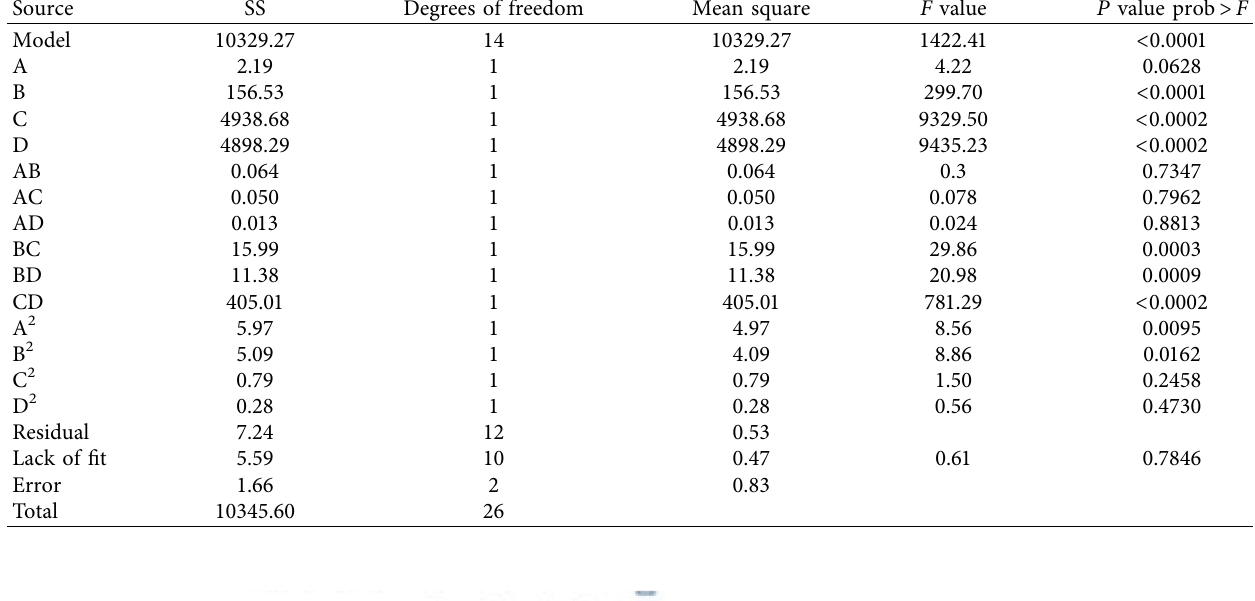
Table 8: ANOVA for material removal rate.